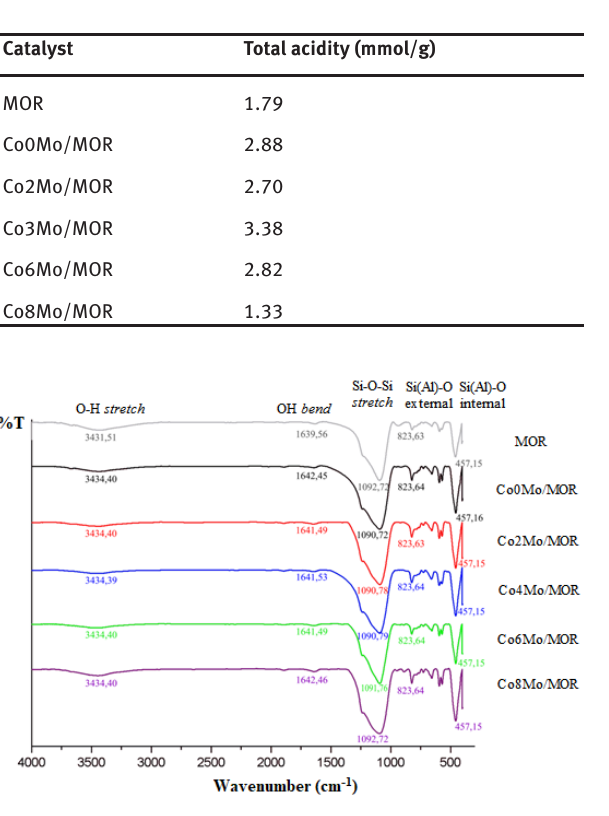
Figure 4: FTIR analysis of MOR and CoMo/MOR.